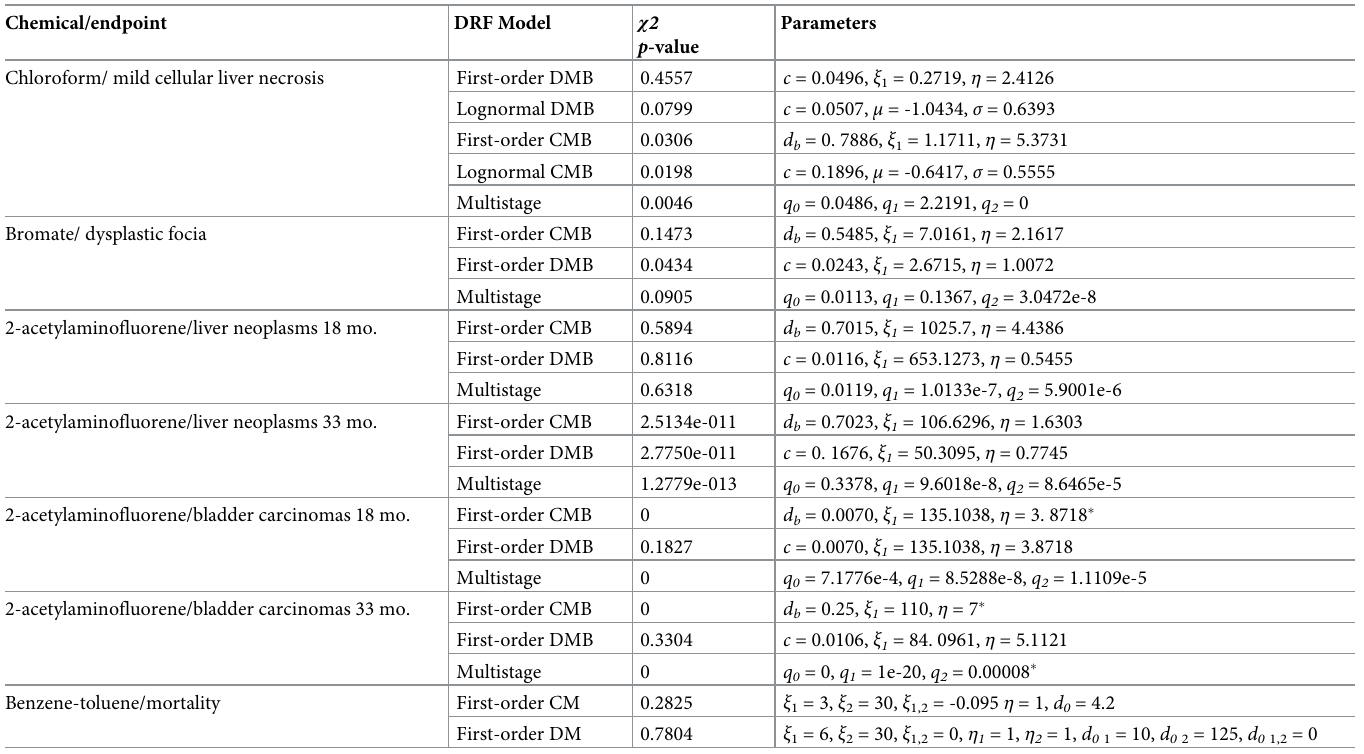
Table 1. Empirical GOF results for all